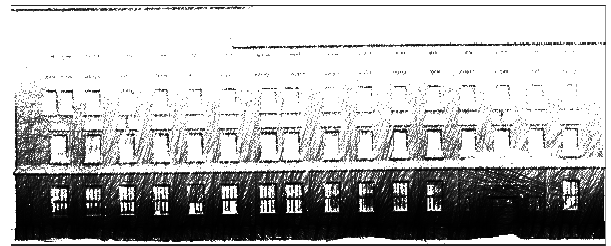
Figure 5. The binary image of façade